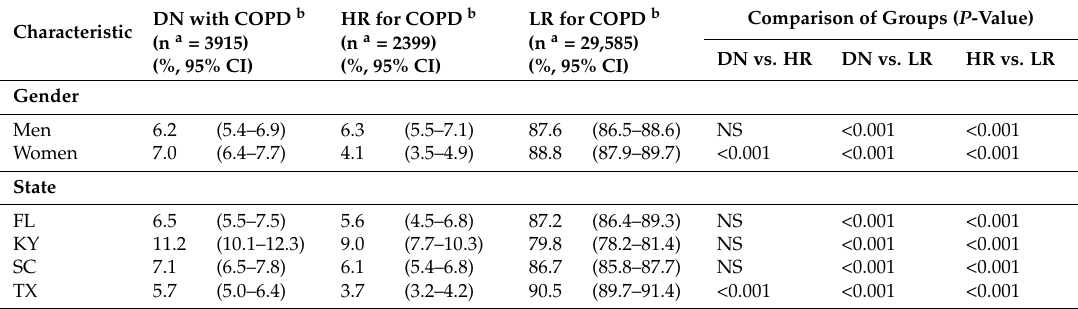
Table 4. State-specific, age-adjusted prevalence of COPD risk-categories among adults ≥ 18 years-old in each of the four states (FL, KY, SC, TX) using the 2015 Behavioral Risk Factor Surveillance system telephone survey.